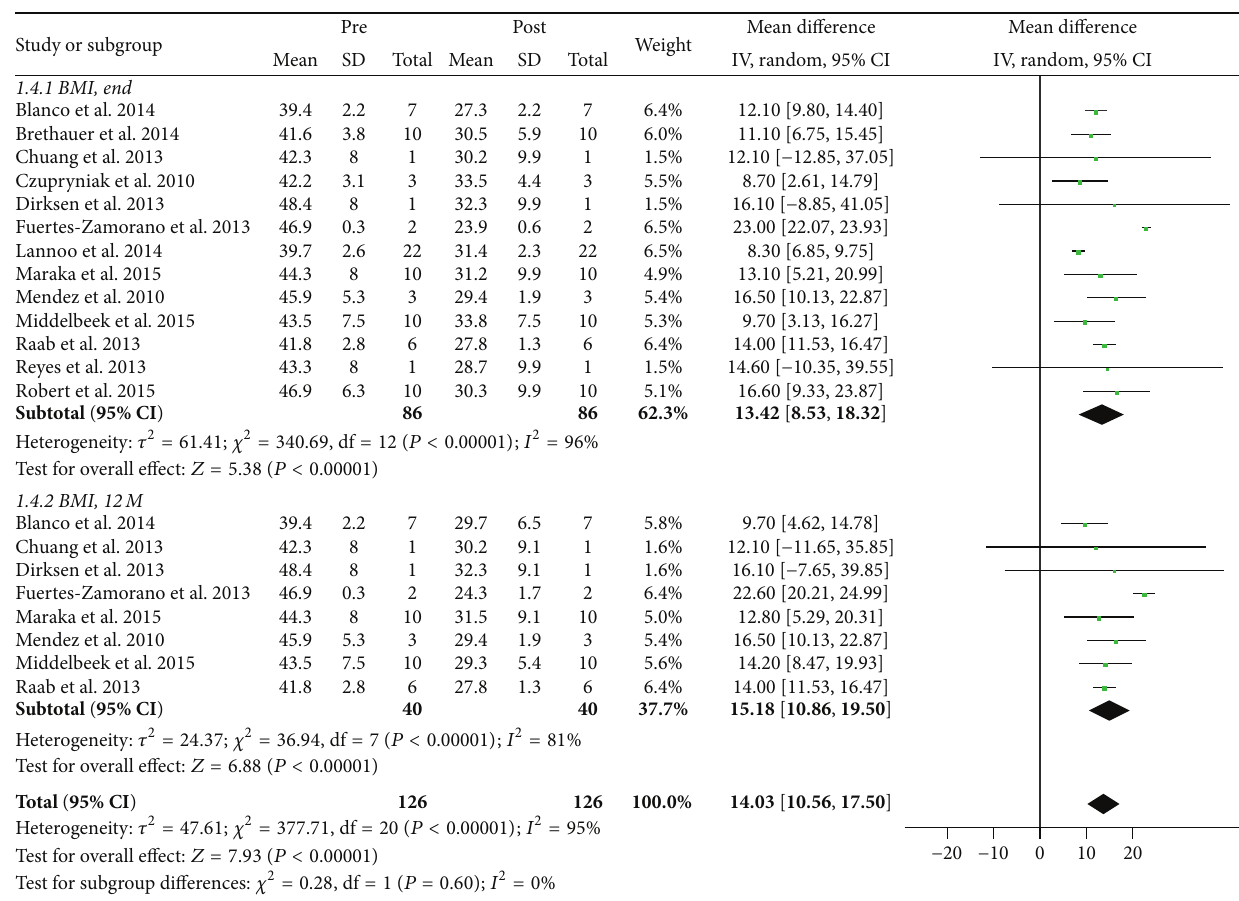
Figure 2: Meta-analysis of changes to BMI postoperatively at 12 months and at study endpoint. End indicates study endpoint; 12 M, at 12 months; pre, preoperative; post, postoperative; CI, confidence